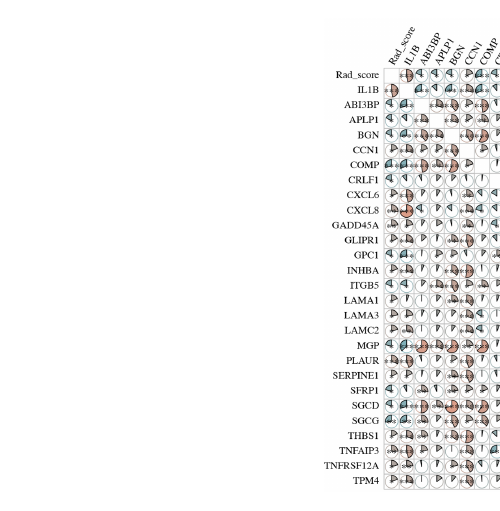
FIGURE 8 The expression level of EMT-related genes and rad-scores in HNSCC. EMT, Epithelial-Mesenchymal Transition; HNSCC, Head and neck squamous cell